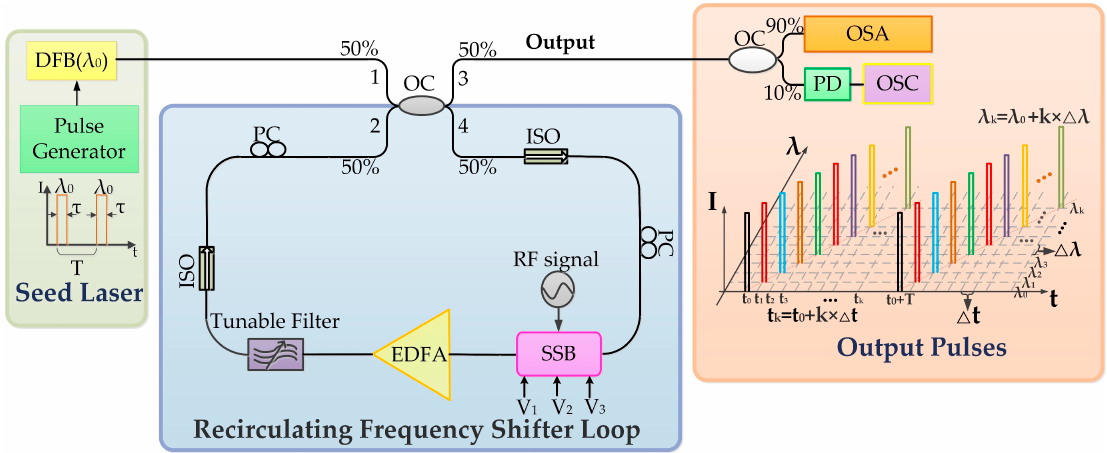
Figure 1. The principle setup of the wavelength step-swept laser source. DFB: Distributed feedback laser; PG: Pulse generator; OC: Optical coupler; ISO: Isolator; PC: Polarization controller; SSB: Single-side-band modulator; RF: Radio frequency; EDFA: Erbium-doped fiber amplifier; PD: Photodetector; OSA: Optical spectrum analyzer; OSC: Oscilloscope.